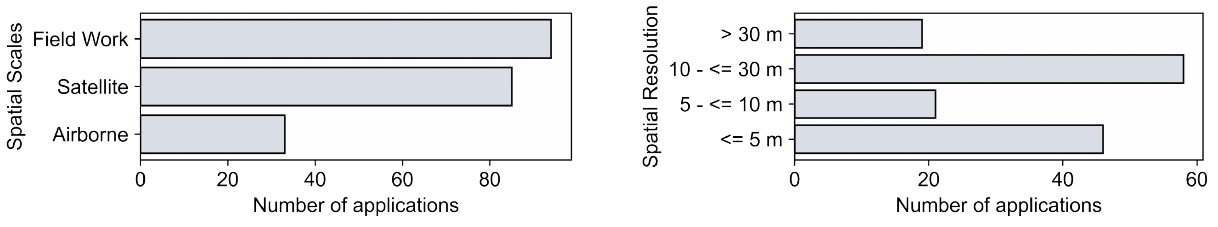
Figure 8. Comparison of the spatial scales (field work, spaceborne, airborne remote sensing) and spatial resolutions of remote sensing data of the reviewed